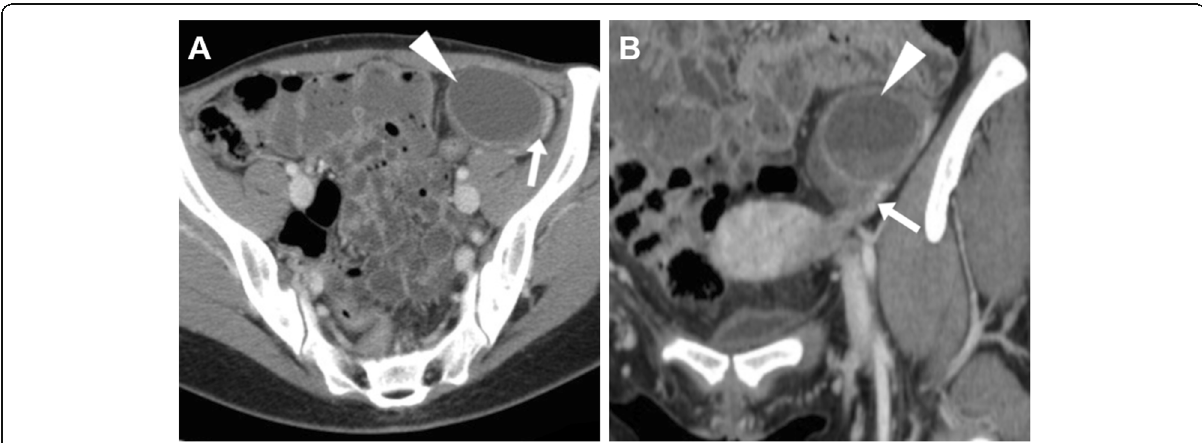
Fig. 3 Uncomplicated, symptomatic follicular ovarian cyst causing left lower quadrant pain. Axial ( a ) and coronal ( b ) CT images show a 4 × 3 cm cystic mass (arrowheads) with homogeneous fluid attenuation, laterally displaced in the left hemipelvis. Identification of the ovarian vessels in the suspensory ligament (arrows) helps in confirming the adnexal origin of the